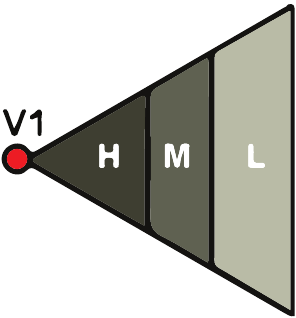
Figure 5. Content quality assuming regions of